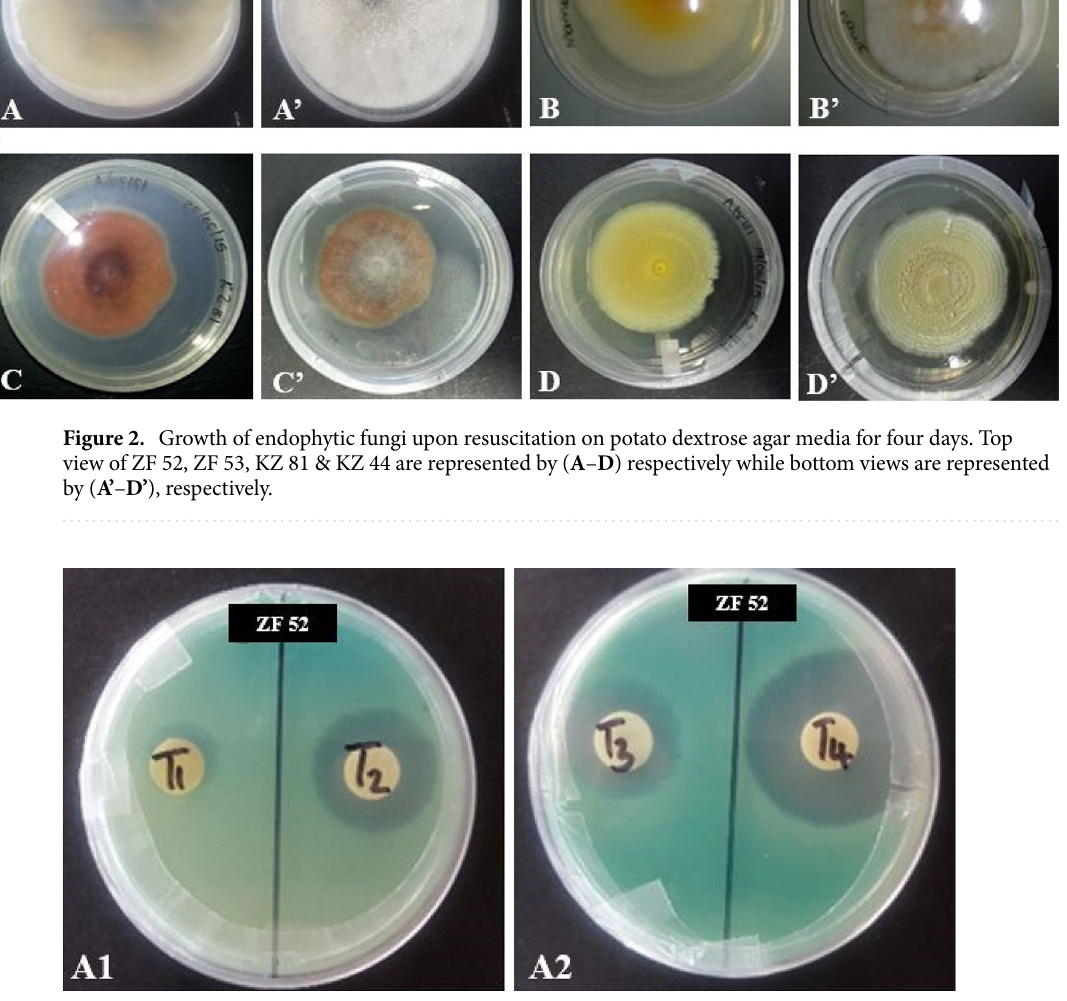
Figure 3. Kirby Bauer disc diffusion assay demonstrating anti- Pseudomonas aeruginosa activity of ZF 52 extracts after varying fermentation periods (T1, T2, T3, and T4 represent 1, 2, 3 and 4 weeks, respectively).